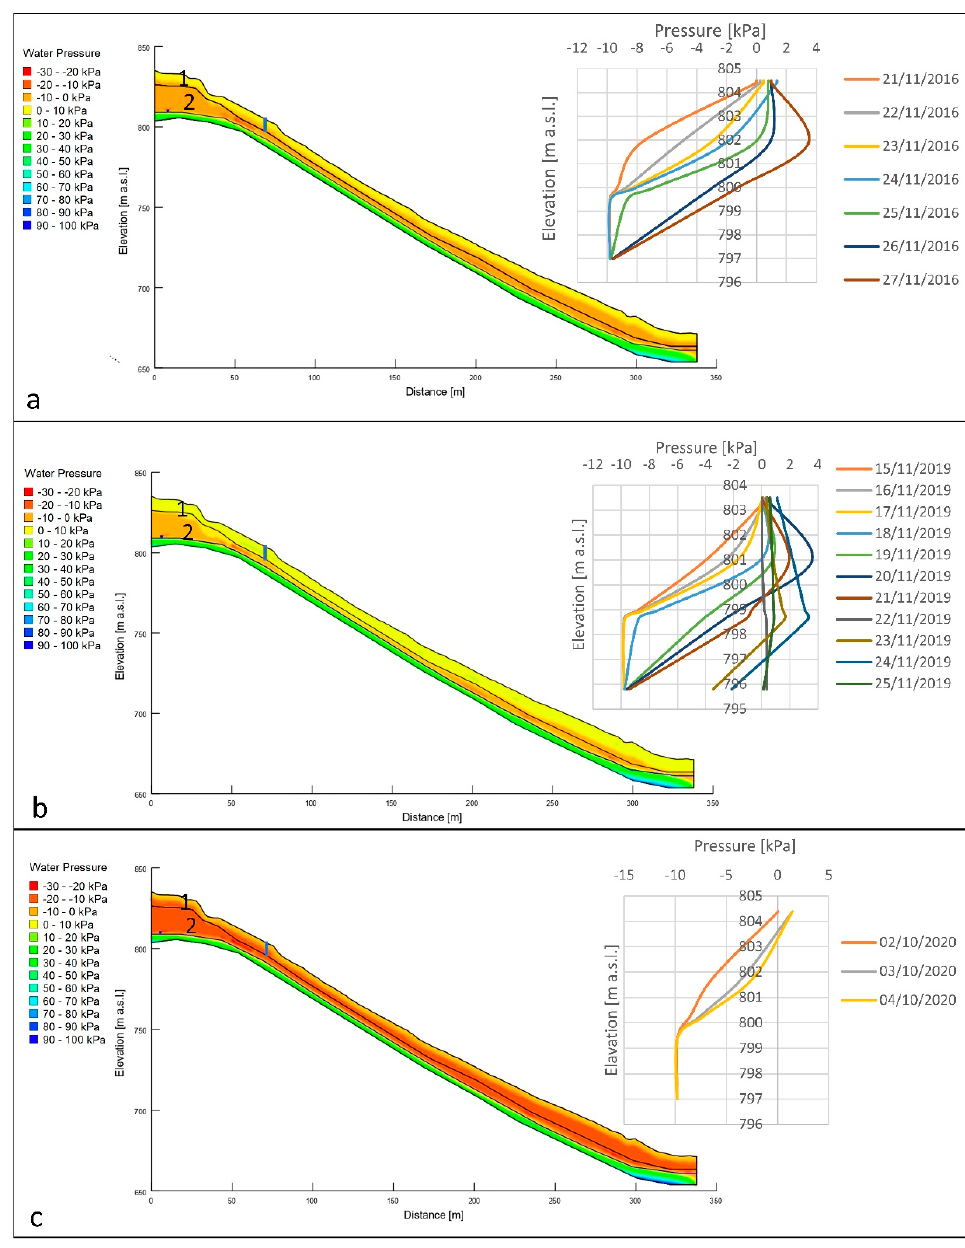
Figure 11. Distribution of interstitial pressures in the slope (section B–B’) during selected time steps: ( a ) November 2016 event; ( b ) November 2019 event; and ( c ) October 2020 event. The blue line in the image represents the vertical transect for which the changes in interstitial pressures shown in the graphs were analysed. 1 Layer 1; and 2 Layer 2.